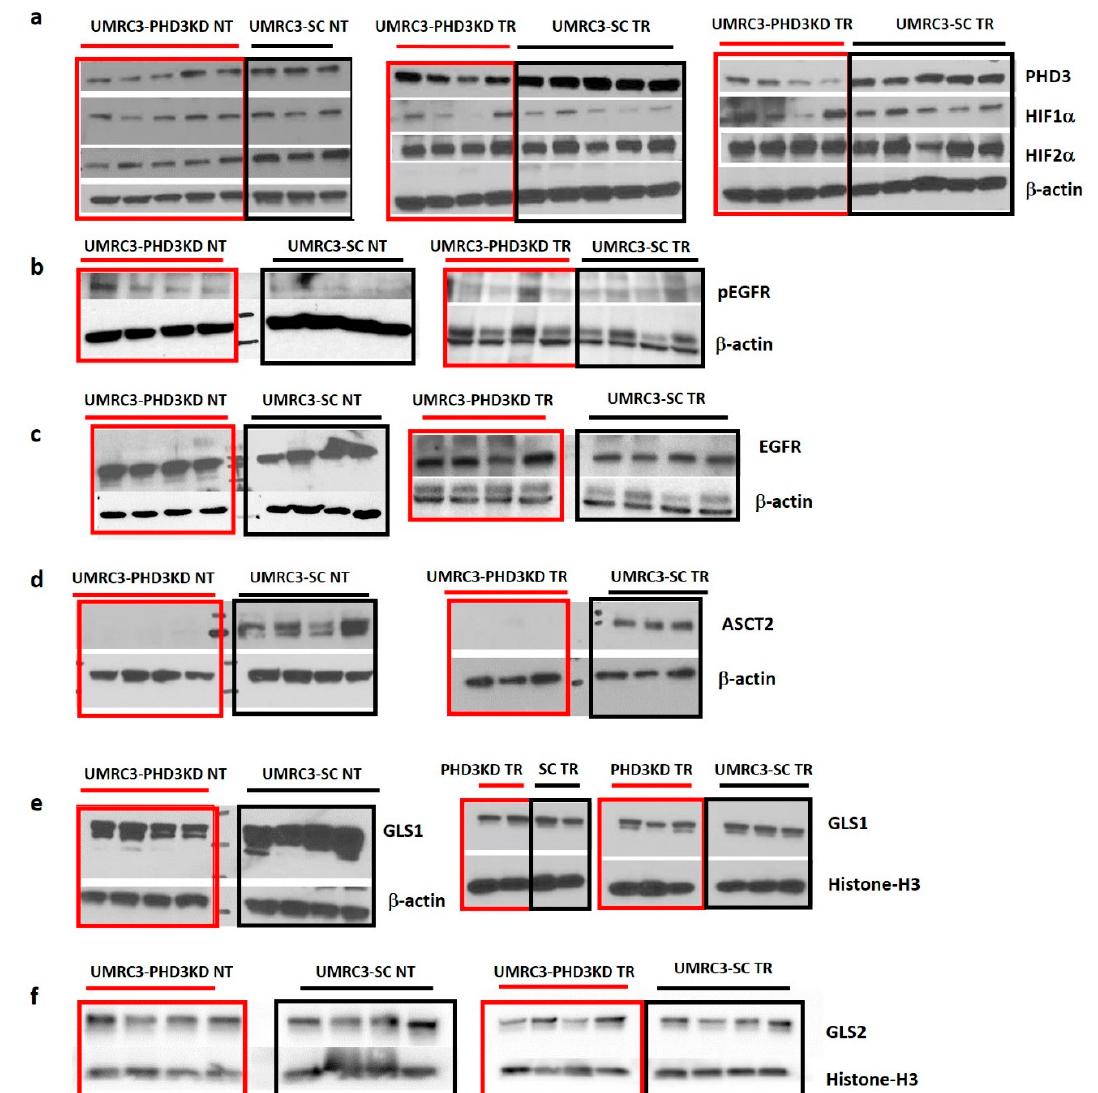
Figure 4. PHD3 knockdown reduced HIF2 α expression and increased pEGFR expression in untreated tumors (NT). This effect disappeared after sunitinib treatment (TR). UMRC3-PHD3KD tumor samples are highlighted in red boxes while UMRC3-SC tumor samples are highlighted in black boxes. Densitometry ratio measurements of each protein over the loading control shown in Table 1. ( a ) Western analysis and densitometry revealed that untreated UMRC3-PHD3KD tumors had slightly lower PHD3 expression but significantly lower HIF2 α expression ( p < 0.002) compared to untreated